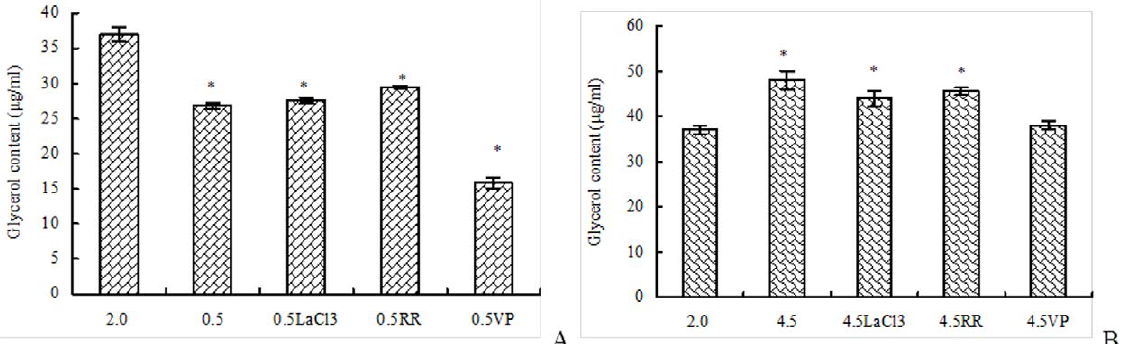
Figure 3. Effect of Ca 2 + channel blockers on glycerol content in D.salina under hypoosmotic or hyperosmotic stress. A: Hypoosmotic stress; B: Hyperosmotic stress. Columns represent the means of three replicated studies in each sample, with the SD of the means (T test, p , 0.001). The significance of the differences between the control (2.0) and test values were tested by using one-way ANOVA. *, p , 0.05 vs control.